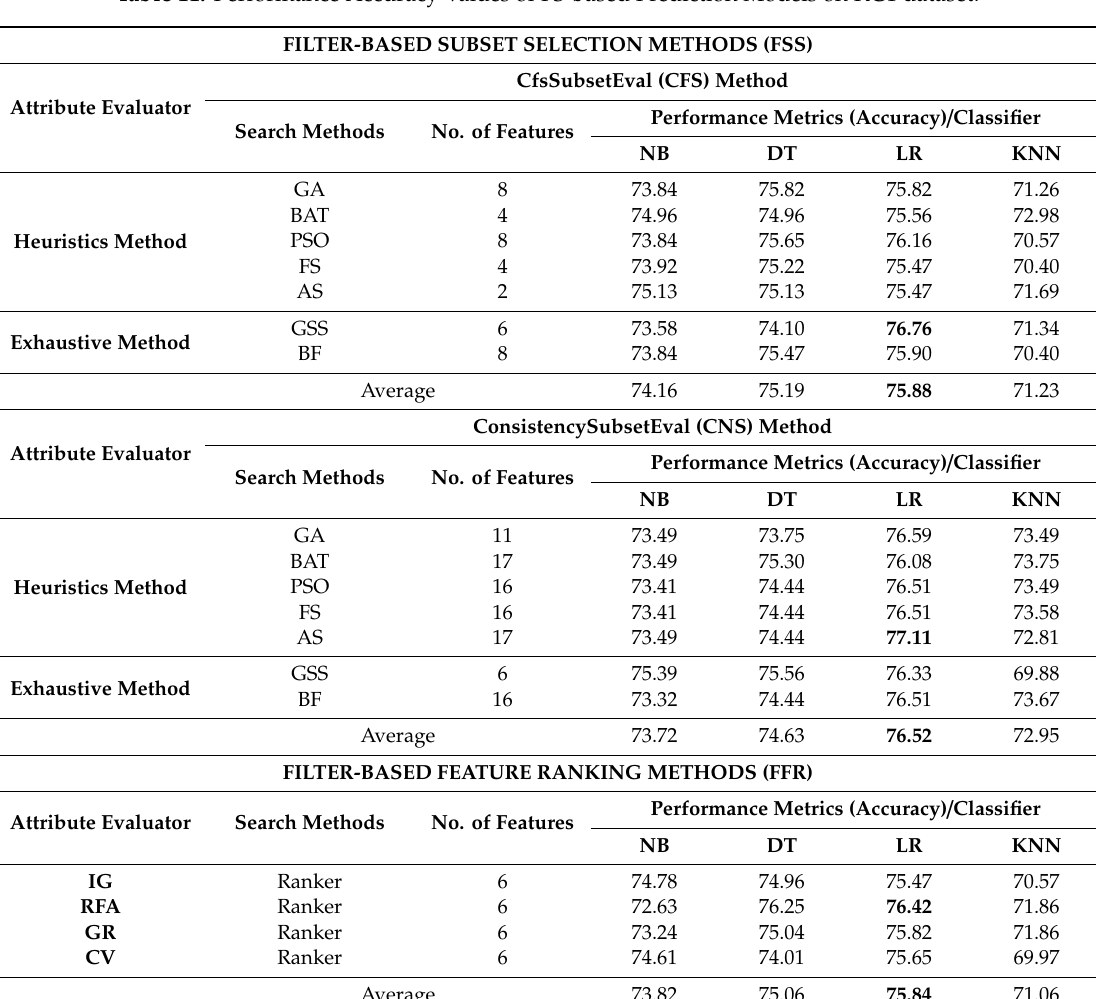
Table 11. Performance Accuracy Values of FS-based Prediction Models on KC1 dataset.